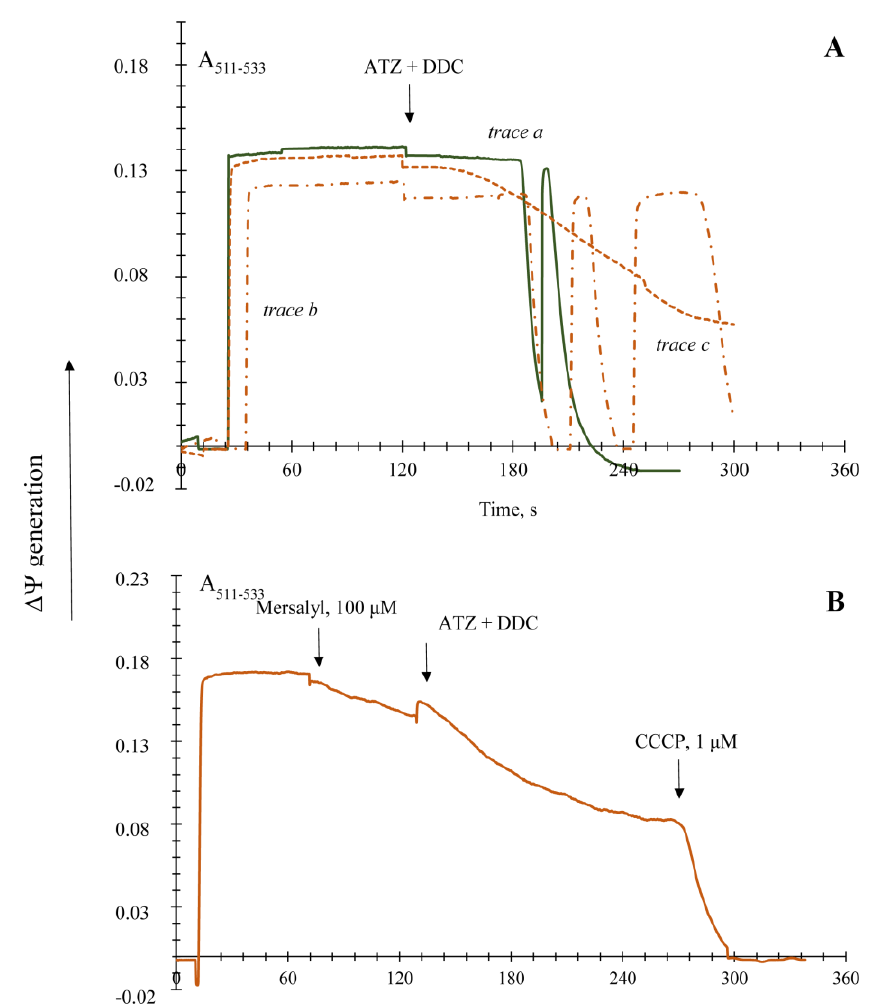
Figure 3. Effects of phosphate (Pi) and mersalyl on non-specific permeability transition induction in the E. magnusii mitochondria respiring on a pyruvate and malate system in the presence of the antioxidant enzyme inhibitors. The incubation medium was the same as that in Figure 1, Panel ( A ): incubation medium contained also 2 mM Pi (trace a), 4 mM Pi (trace b), and 5 mM Pi (trace c); Panel ( B ): 100 μM mersalyl was added into the medium before the inhibitors. Addition of the inhibitors mixture (4 mM DDC and 4mM ATZ) is indicated by the arrow.